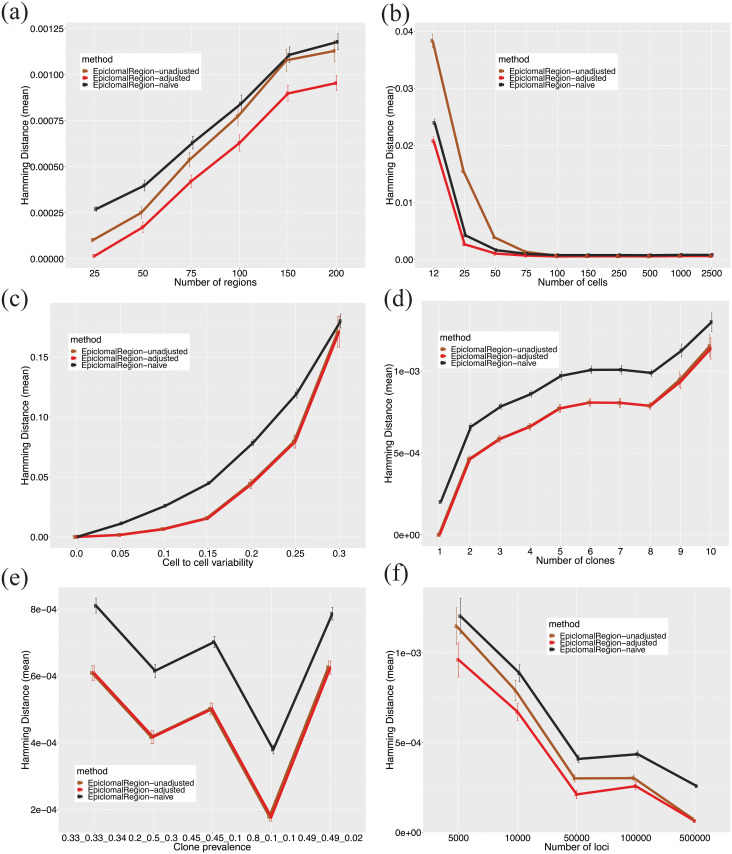
Imputation results on synthetic data.Average hamming distance for three variants of EpiclomalRegion inferred methylation states: unadjusted, adjusted, and naive (see Sections 1.2 and 3.4 in S1 Material) when varying: (a) the number of regions, (b) the number of cells, (c) the cell-to-cell variability, (d) the number of clones, (e) the cluster frequencies (prevalences), and (f) the number of loci. The vertical bars correspond to one standard deviation above and below the mean value.